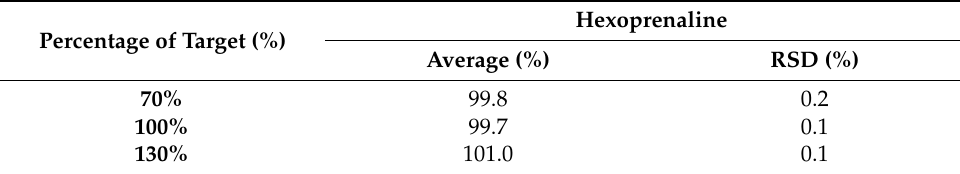
Table 5. Accuracy results from method validation.